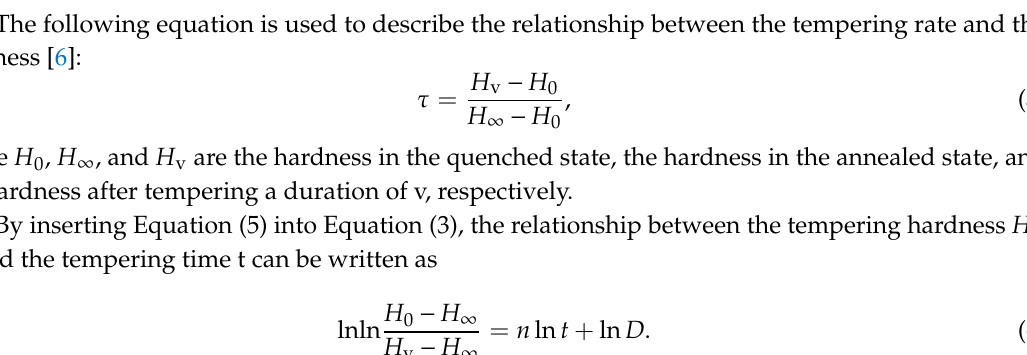
Figure 11. Dislocation density as a function of the tempering duration.